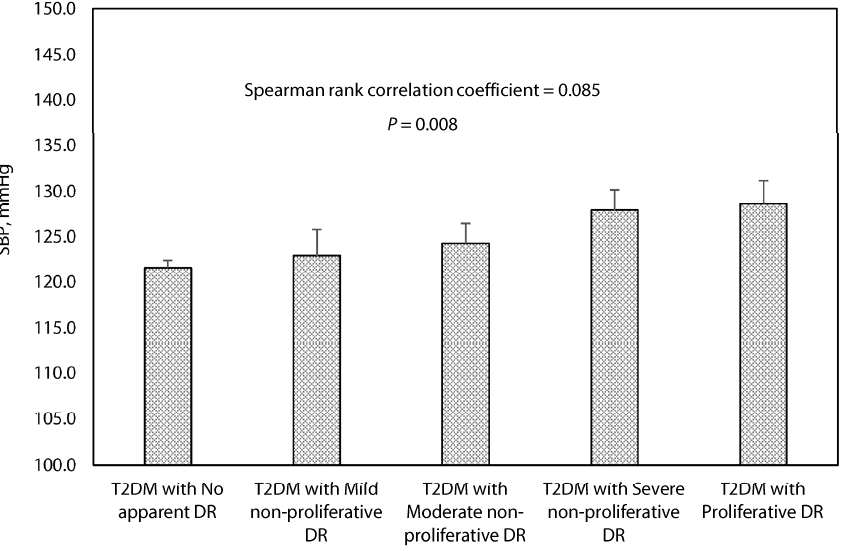
Figure 2. Association between systolic blood pressure and the grading of diabetic retinopathy in T2DM patients without hypertension. Error bars indicate 95% confidence interval. BP, blood pressure; DR, diabetic retinopathy. The stages of diabetic retinopathy are classified using the International Classification of DR Scale. Reference: International Diabetes Federation and the Fred Hollows Foun- dation. Diabetes eye health: a guide for health care professionals. Brussels, Belgium: International Diabetes Federation,